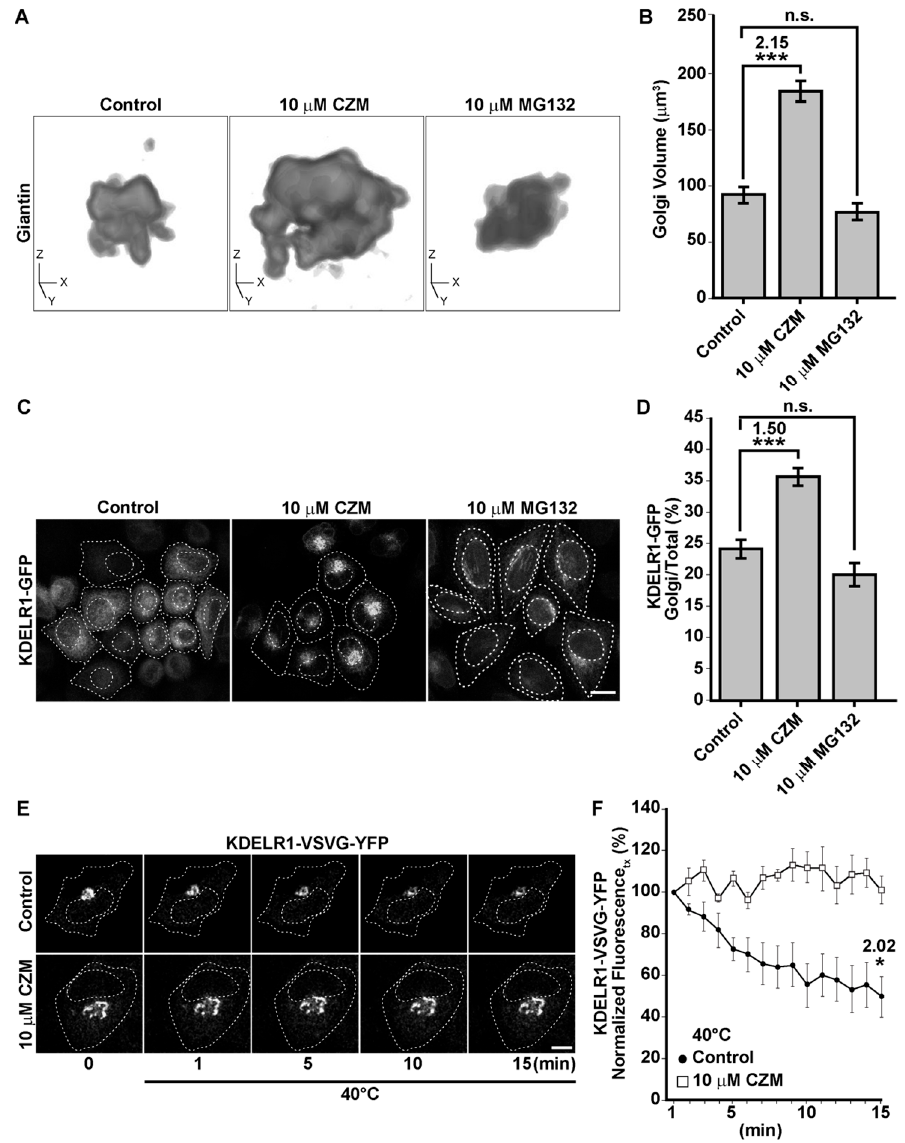
Figure 5. The PSMD14 DUB inhibitor CZM impairs Golgi-to-ER retrograde transport. ( A ) Three-dimensional reconstructions of the Golgi apparatus using giantin as a Golgi marker were generated from Z-stacks (250 nm) obtained from HeLa cells stably expressing KDELR1-GFP treated for 90 min either with vehicle (DMSO; Control), CZM or MG132. ( B ) Golgi volume was measured from 3D reconstructions as shown in ( A ). Statistical significance was determined by Student’s t-test. Bars represent the means ± SEM ( n = 30 cells). *** p < 0.001. ( C ) HeLa cells stably expressing KDELR1-GFP were treated for 90 min either with vehicle (DMSO; Control), CZM or MG132. Cells were fixed, and representative confocal images were acquired. ( D ) Measurement of giantin and total KDELR1-GFP total fluorescent intensity. Statistical significance was determined by Student’s t-test. Bars represent the means ± SEM ( n = 34 cells). *** p < 0.001. ( E ) H4 cells were transiently transfected to express the thermo-sensitive retrograde transport reporter KDELR-VSVG-YFP. Cells were kept at 32 ◦ C to allow KDELR-VSVG-YFP localization at the Golgi. Cells were then shifted to 40 ◦ C (restrictive temperature) and images acquired at 1 min interval for 15 min. ( F ) Quantitative image analysis was performed to measure the integrated fluorescence of KDELR-VSVG-YFP at the Golgi at 1 min interval for 15 min. Statistical significance was determined by Student’s t-test. Bars represent the mean ± SEM ( n = 3 cells). * p <